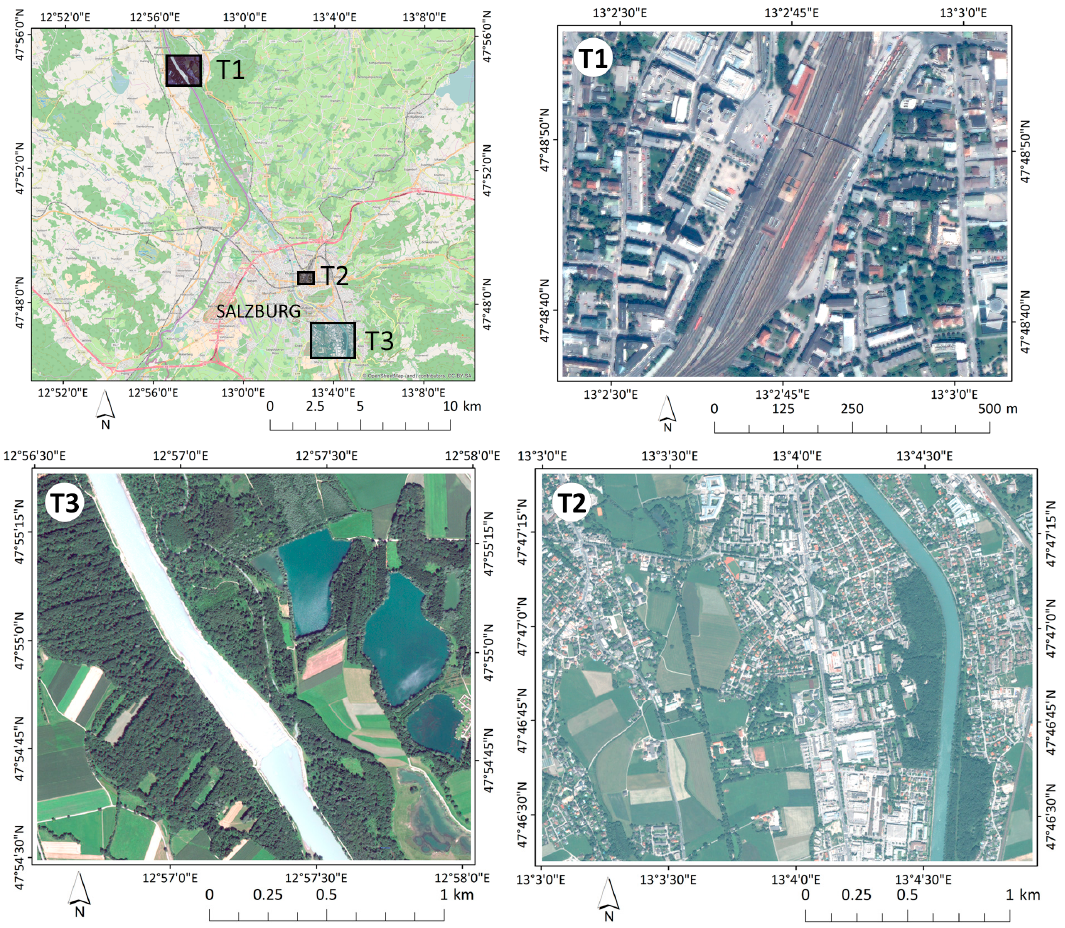
Figure 1. The three test areas under investigation (T1 to T3), as detailed in Table 1.